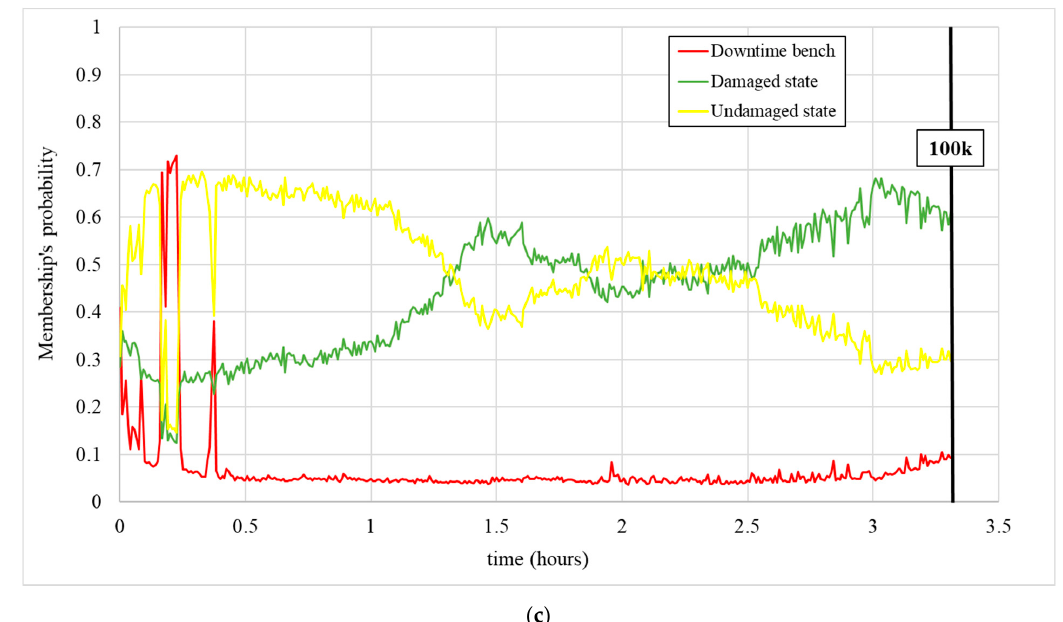
Figure 9. Probability of belonging to one of the three states (damaged, undamaged, downtime) deriving from the elaboration of the datasets carried out with k-means for the validation tests V01 ( a ), V02 ( b ), and V03 ( c ).